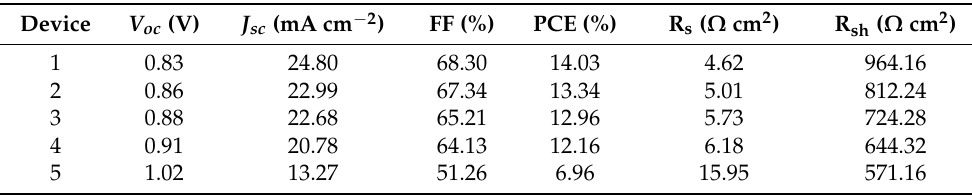
Table 1. Performance parameters of devices 1 to 5.